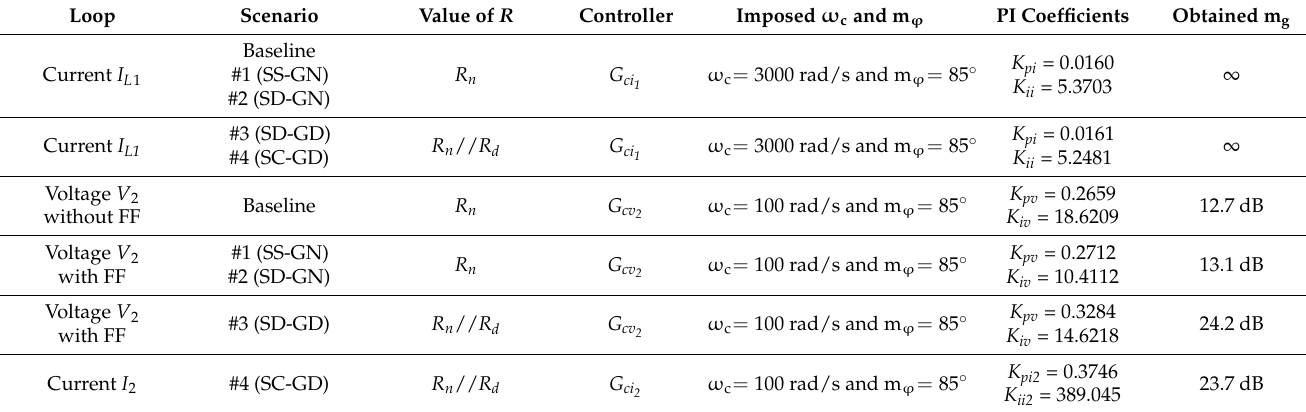
Table 5. Coefficients of PI regulators in the case of model A.